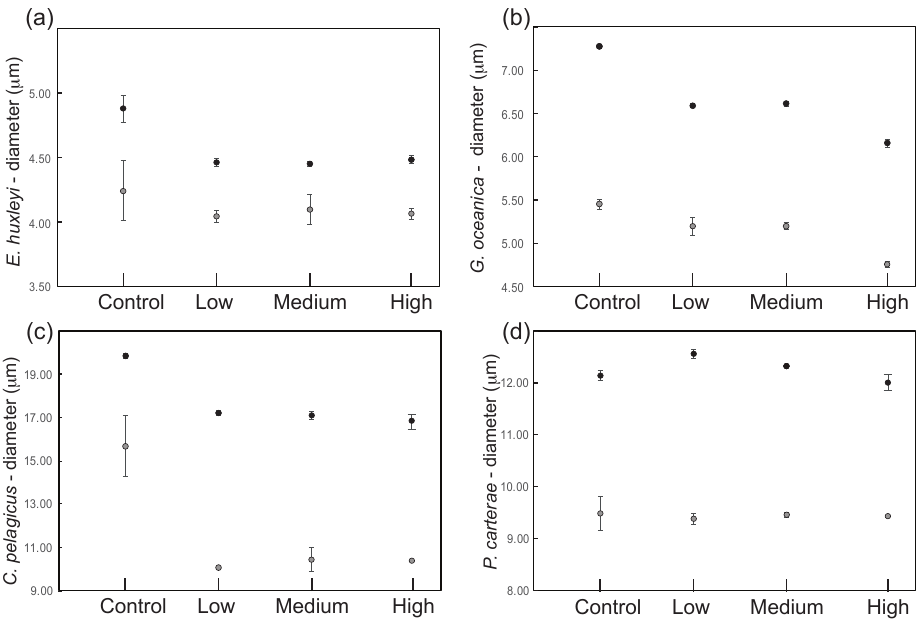
Figure 4. Average values of the coccolithophore diameters (black dots) and cell diameters (gray dots). All measurements were done in triplicates; error bars denote standard deviation. If not visible, error bars are smaller than symbols. (a) E. huxleyi; (b) G. oceanica ; (c) C. pelagicus ; (d) P. carterae. Note the different scales on the y axis.